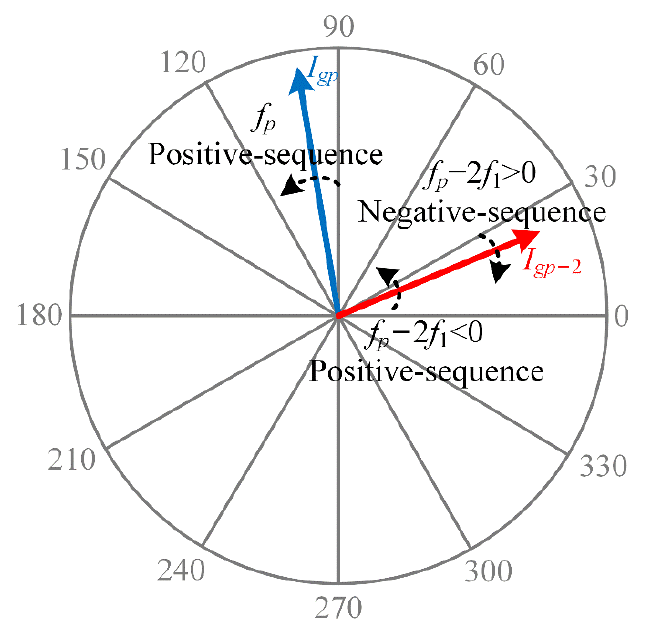
Figure 4. Sequence of the perturbation currents in MMC.